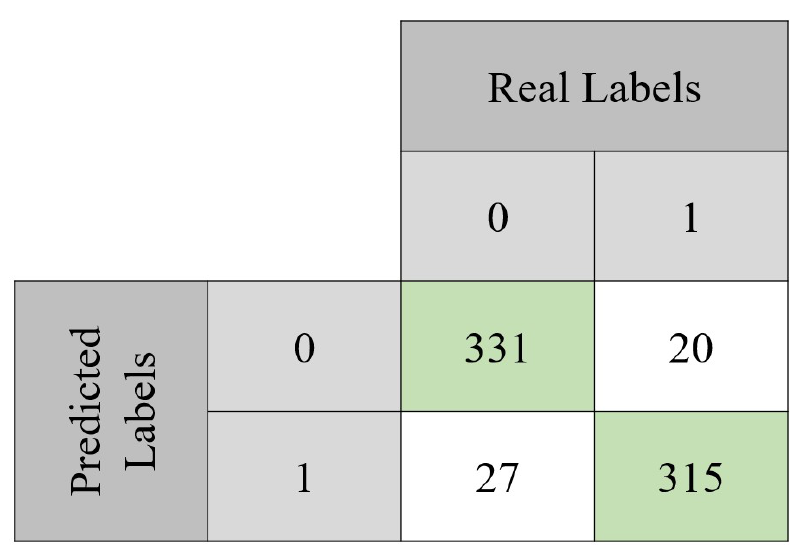
Figure 7. Confusion matrix obtained with the test set. From the total 693 instances, the model was capable of correctly classify 646 of them. It can also be noted that approximately 92% of the benign lesions were correctly classified, while for the malignant lesions, the same happened for approximately 94% of